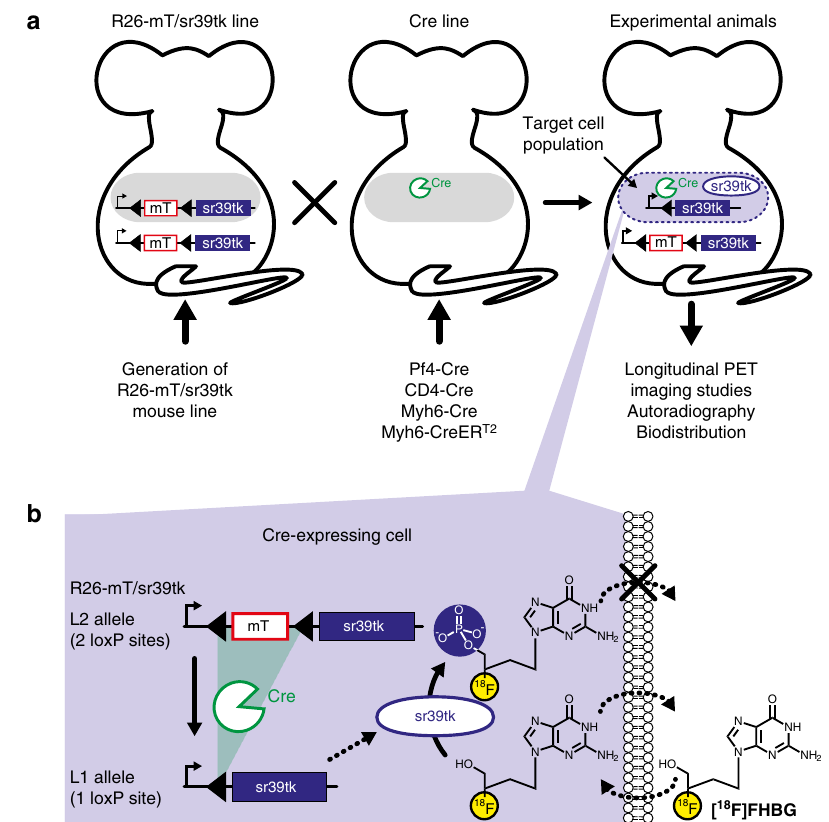
Fig. 1 Strategy for PET-based cell tracking with the R26-mT/sr39tk mouse line. a Generation of experimental animals for PET imaging. R26-mT/sr39tk mice carry the Cre-activatable R26-mT/sr39tk transgene that has been integrated via homologous recombination into the Rosa26 (R26) locus. In R26-mT/sr39tk mice, sr39tk expression is blocked by a loxP- fl anked ( triangles ) gene cassette encoding membrane-targeted tandem dimer tomato red fl uorescent protein (mT). R26-mT/sr39tk mice are mated with mice that express Cre (or CreER T2 ) under control of a cell type-speci fi c promoter (e.g., Pf4, CD4 or Myh6). In progeny mice, Cre recombination activates sr39tk expression in the respective target cell population (blue shaded oval) as shown in detail in b . b Strategy for Cre-dependent sr39tk expression and labeling of distinct cell types. The R26-mT/sr39tk L2 allele (carrying two loxP